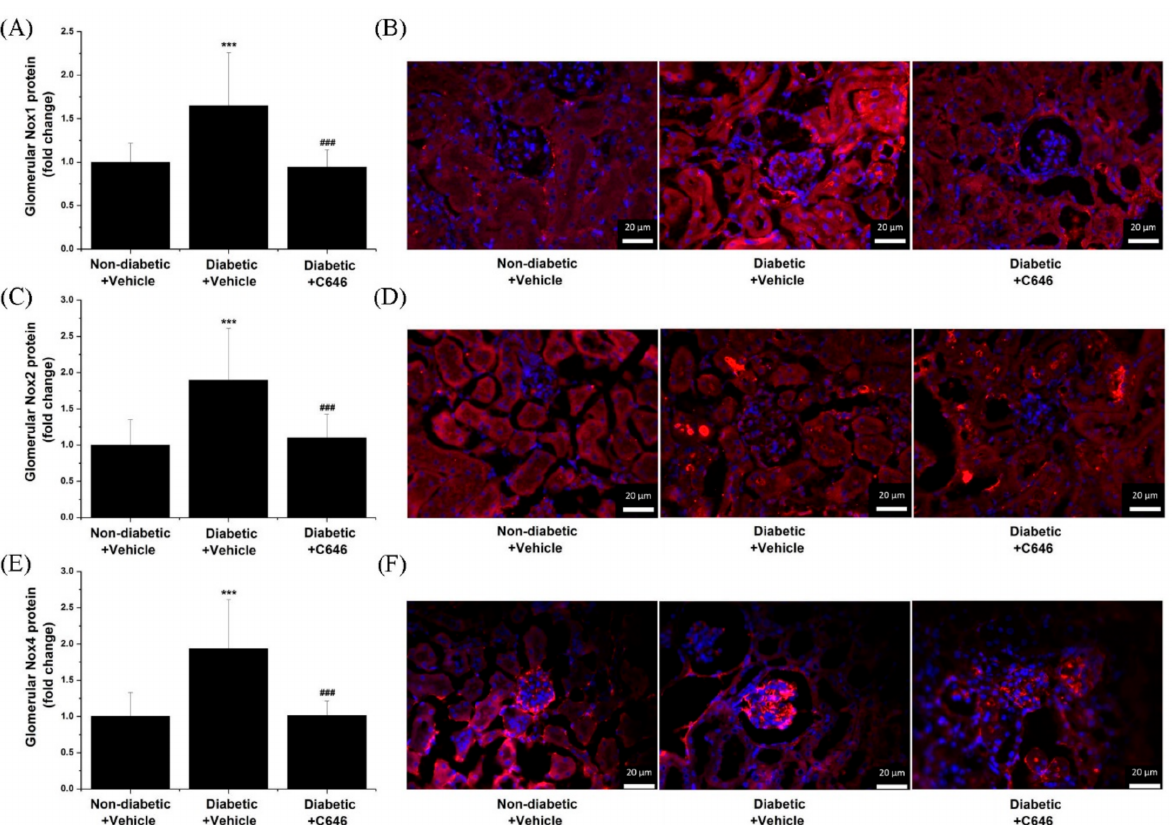
Figure 4. Pharmacological inhibition of histone acetyltransferase p300/CBP by C646 mitigates the glomerular expres- sion of Nox subtypes in diabetic mice. ( A , C , E ) Quantification of fluorescence immunolabeling for glomerular Nox1, Nox2, and Nox4 subtypes. ( B , D , F ) Representative IF microscopy images taken at 40 × magnification depicting the immunofluorescence staining (red) for Nox subtypes. Sections were counterstained with DAPI (blue) stain to de- tect the cell nuclei in the specimens. Note that the up-regulation of glomerular Nox1, Nox2, and Nox4 protein lev- els in diabetic mice is blunted following C646 treatment. n = 14–19/condition quantified glomeruli, *** p < 0.001, p -values taken in relation to non-diabetic + vehicle condition; ### p < 0.001, p -values taken in relation to diabetic + vehicle